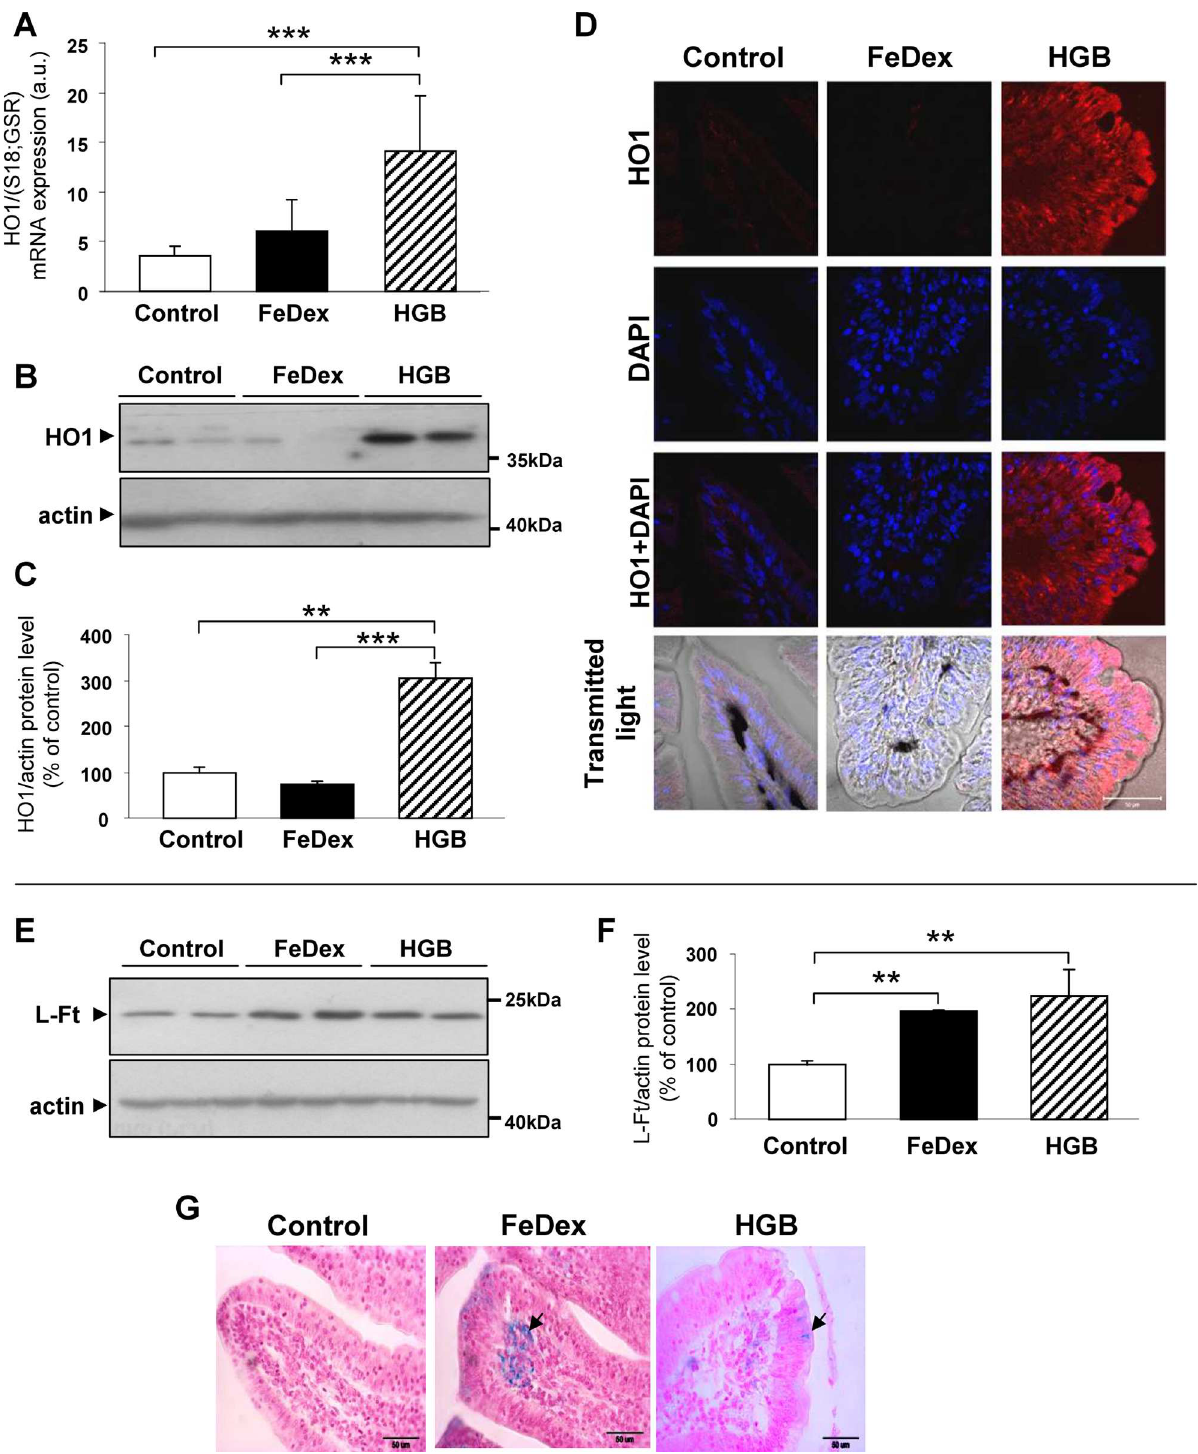
Fig 4. Induction of HO1 expression and increased iron status in duodenal enterocytes from hemoglobin-supplemented piglets. (A) RT-qPCR analysisof HO1 mRNA expression. The histogramdisplaysHO1 mRNA levels in arbitrary units (means ± S.D., n = 7). (B and C) Western blot analysisof HO1 protein levels in membranefractions preparedfrom duodenalscrapings.A representative immunoblot is shown (B) . ImmunolabelledHO1 bandsfrom separateblots performed on scrapingsisolated from 6 piglets were quantifiedusing a MolecularImager, and HO1 protein levels (means ± S.D.) are plotted in arbitrary units (C) . (D) Immunofluorescent staining of HO1 in the